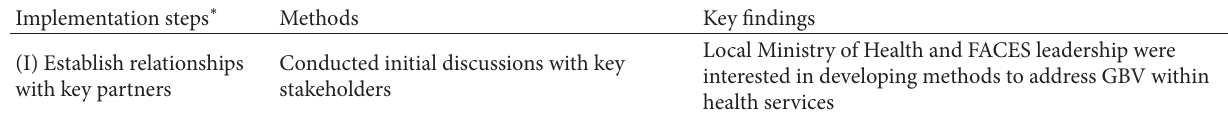
Table 1: Approach for implementing an integrated community-supported clinic-based GBV